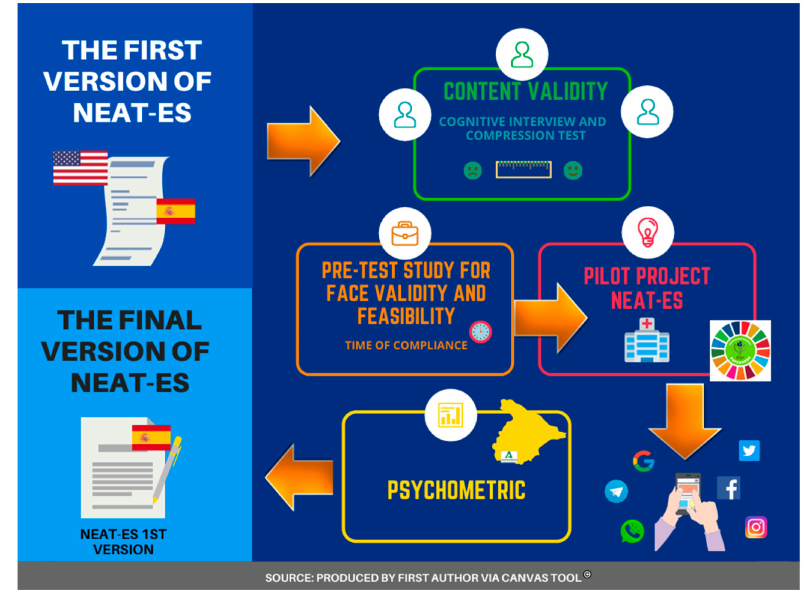
Figure 1. Study design and procedure followed for the